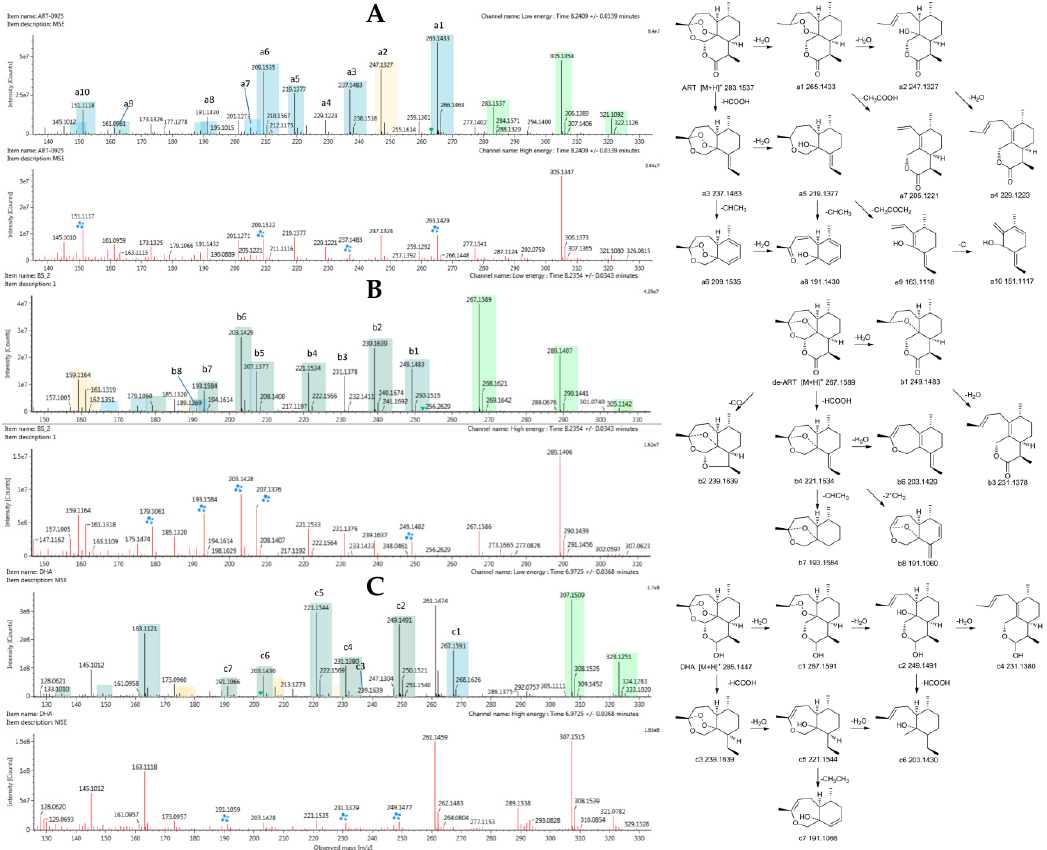
Figure 1. Mass spectrometry (MS E ) spectra ( A ) artemisinin (ART), ( B ) deoxyartemisinin (de-ART), and ( C ) dihydroartemisinin (DHA) as well as the proposed fragmentation pathways. A blue box behind the low-energy fragment ions shows in-source fragment ions and a green box indicates adduct clusters.